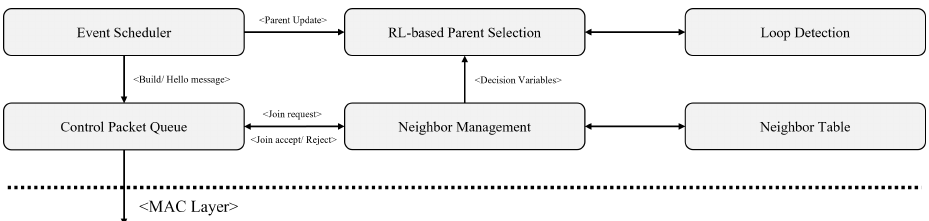
Figure 2. Proposed protocol